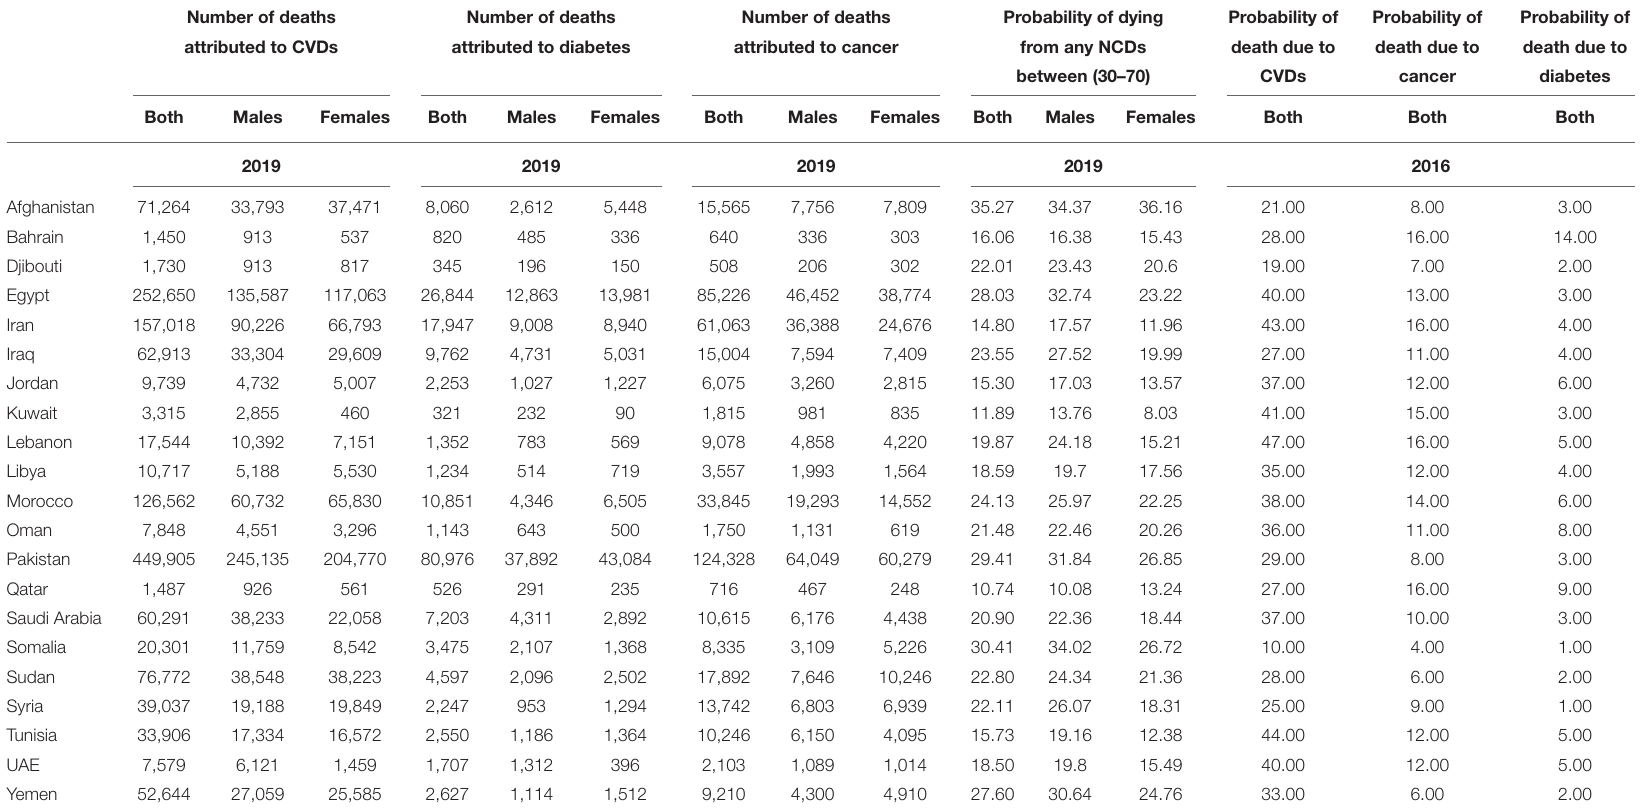
TABLE 1 | Number of deaths and probability of death attributed to CVDs, diabetes, and cancer among adults in EMR